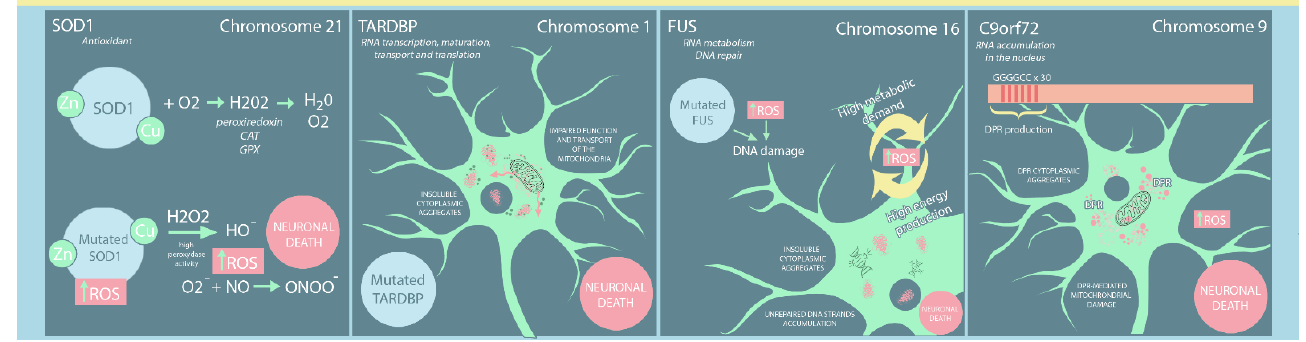
Figure 1. Genetic risk factors involved in oxidative stress in ALS patients. (SOD: superoxide dismutase; ROS: reactive oxygen species; DPR: dipeptide repeat proteins).